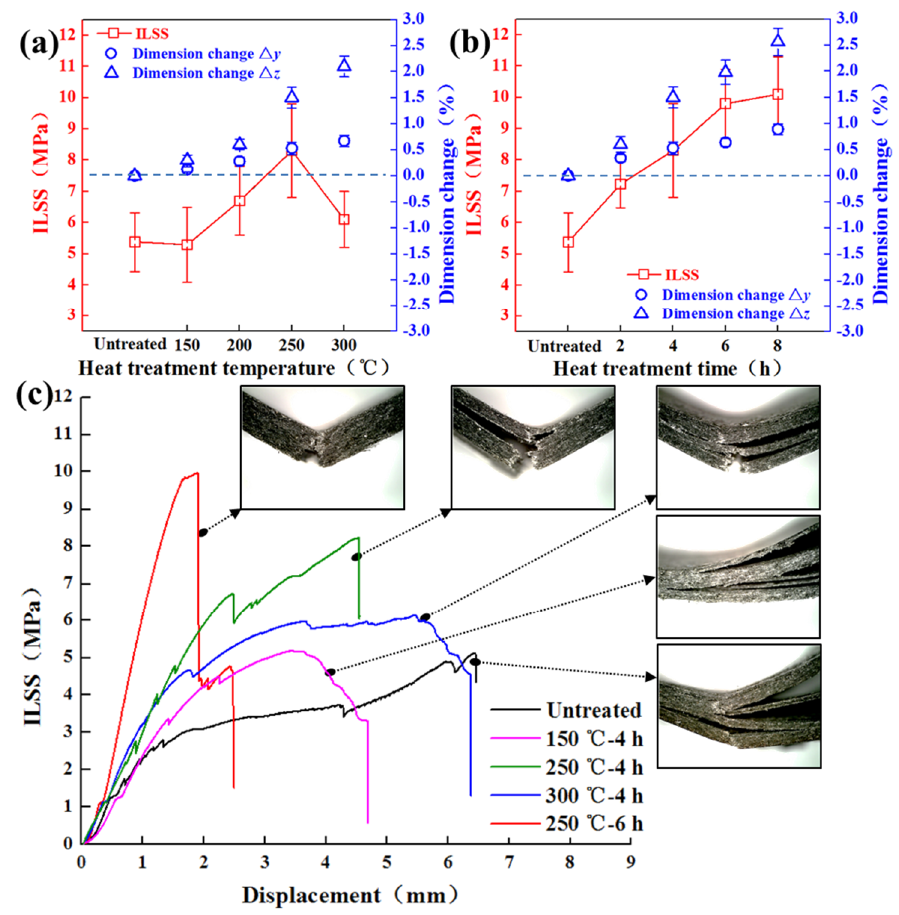
Figure 10. Effect of heat treatment process on ILSS of FDM 3D-printed continuous-fiber-reinforced PEEK composites: ( a ) heat treatment temperature; ( b ) heat treatment time; ( c ) shear stress displacement curves.